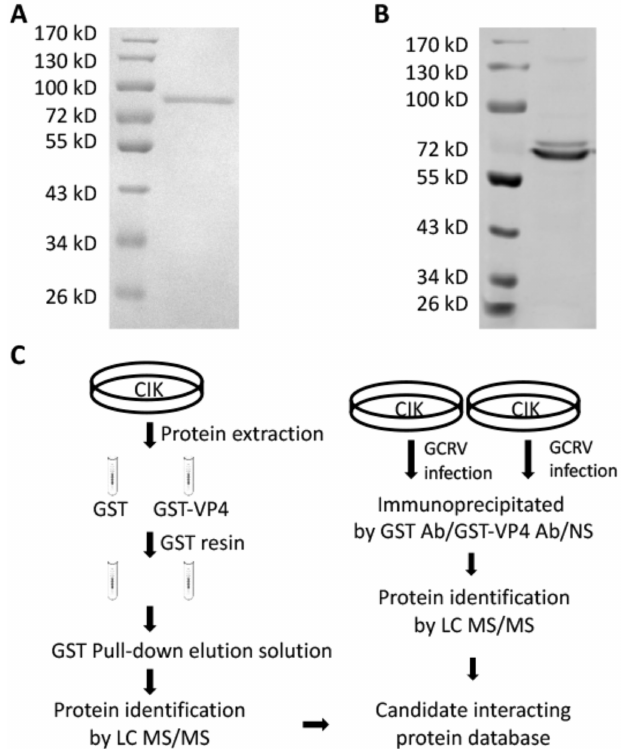
Figure 2. GST pull-down and co-immunoprecipitation (co-IP). ( A ) Purified prokaryotic GST-VP4 recombinant protein was analyzed by SDS-PAGE. Lane 1: Marker; Lane 2: GST-VP4. ( B ) GST-VP4 polyclonal antiserum prepared by our lab was detected by WB using CIK ( C. idella kidney) cell sample infected with grass carp reovirus (GCRV). Lane 1: Marker; Lane 2: CIK protein detected by GST-VP4 antiserum. ( C ) Strategy of GST pull-down and co-IP. Left: Strategy for analyzing the interacting proteins of VP4 via GST pull-down and LC-MS / MS. CIK whole proteins were exacted from CIK cell line and incubated with prokaryotic GST or GST-VP4 protein. Pull-down was carried out with GST resin and the elution was analyzed by LC-MS / MS analysis on a Q Exactive mass spectrometer. Right: Strategy for analyzing the interacting proteins of VP4 via co-IP and LC-MS / MS. CIK cells were infected with GCRV for 24 h and co-IP with GST monoclonal Ab, GST-VP4 polyclonal antiserum or negative serum (NS). LC-MS / MS analysis was performed on a Q Exactive mass spectrometer. One experiment representative of three independent experiments was performed with three biological